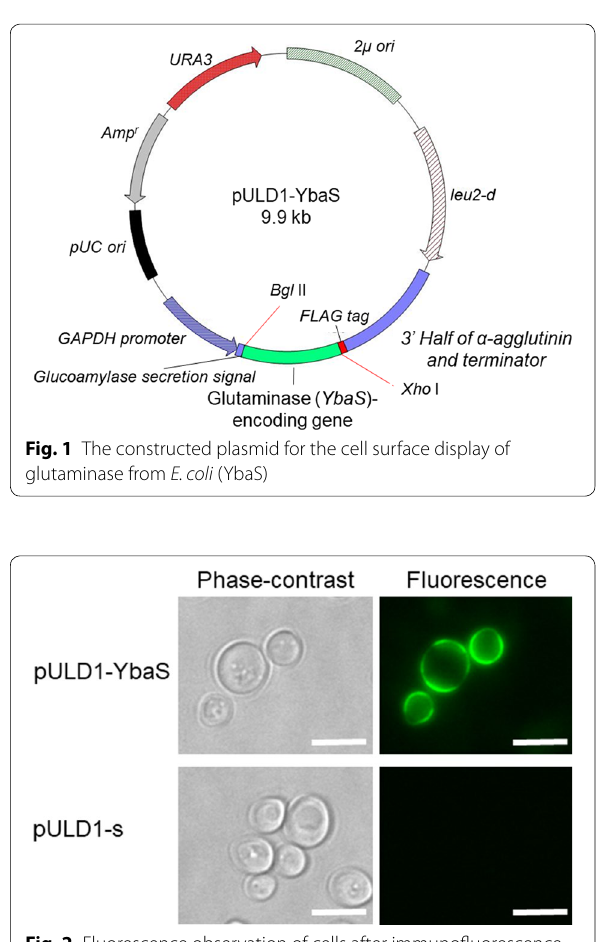
Fig. 2 Fluorescence observation of cells after immunofluorescence labeling. An anti-FLAG antibody and Alexa Fluor 488 anti-mouse IgG antibody were used for labeling of the displayed proteins. Phase-contrast micrographs (left column), fluorescence micrograph (right column). The scale bars are 5 μm